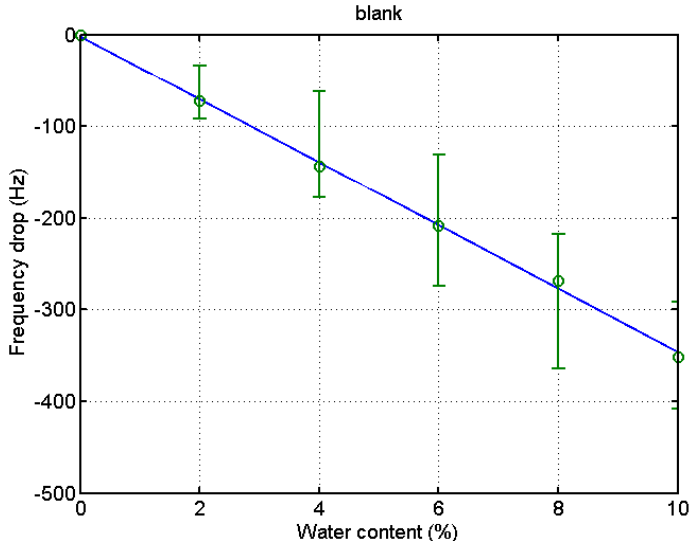
Figure 7. Relationship between water content and resonant frequency shift of a bare quartz crystal microbalance with increased water content in an in-line